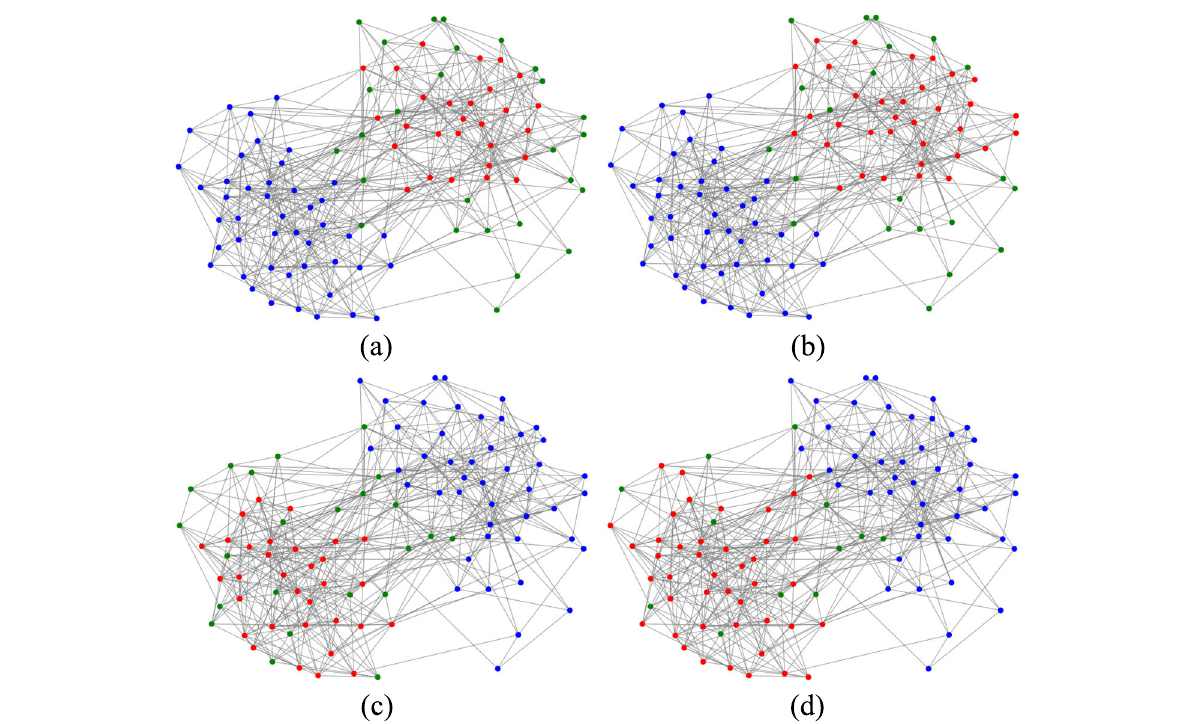
“1” (linking) or “0” (not linking), with linking probability H ( x u , x v ) , i.e.,